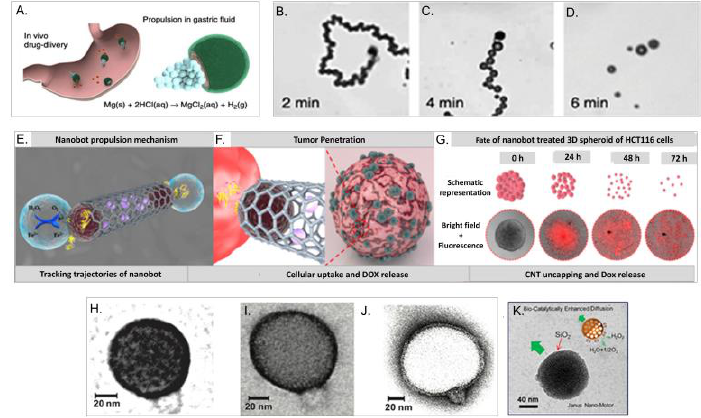
Figure 6. ( A – D ). Schematic illustration of in vivo drug delivery by the propulsion of Mg-based micromotors polymer-coated in a mouse stomach and time lapse images of the micromotor